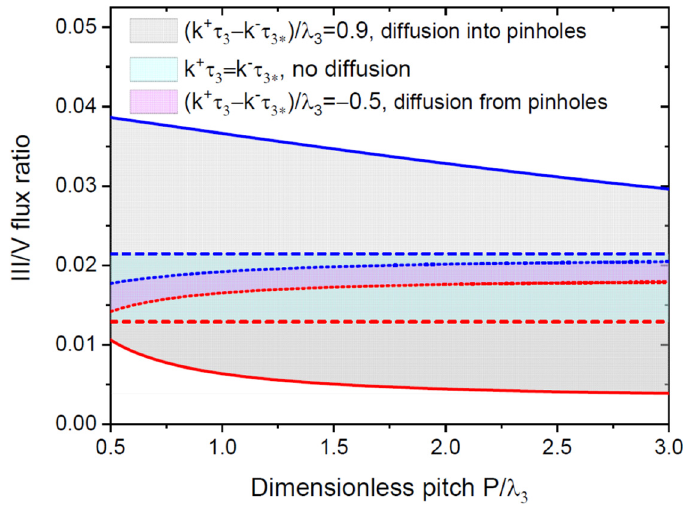
Figure 7. Same as Figure 6 in for the III/V flux ratio versus the dimensionless pitch P / λ 3 . The di- mensionless pinhole radius R / λ 3 is fixed at 0.2.